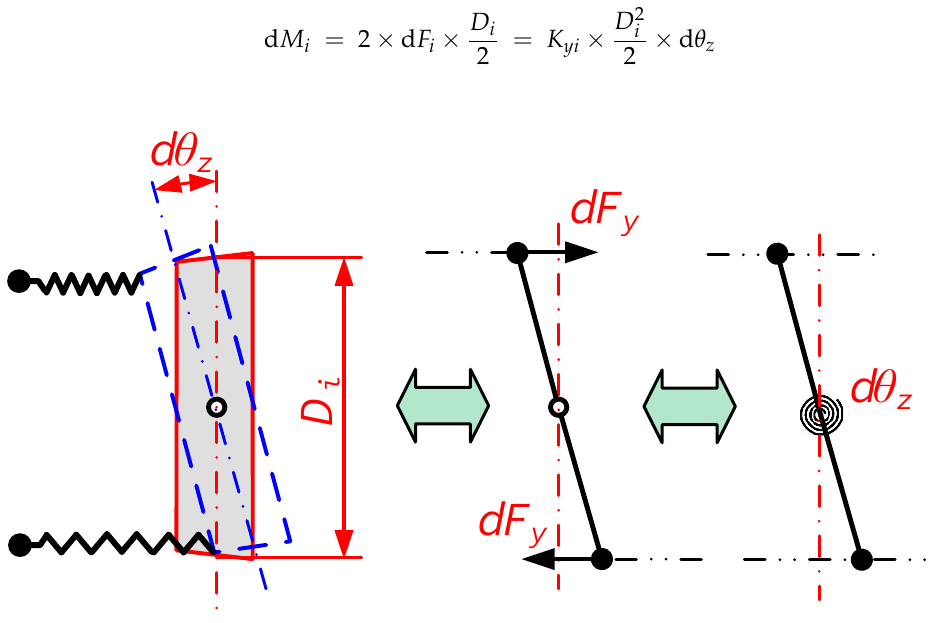
Figure 4. Relationship between axial stiffness and angular stiffness.